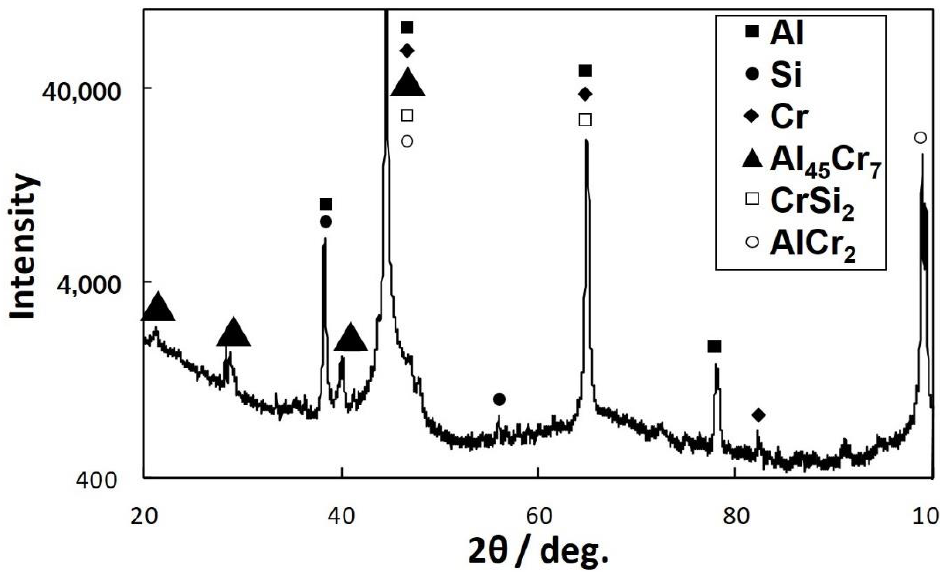
Figure 11. A XRD pattern of sample shown in Figure 9.